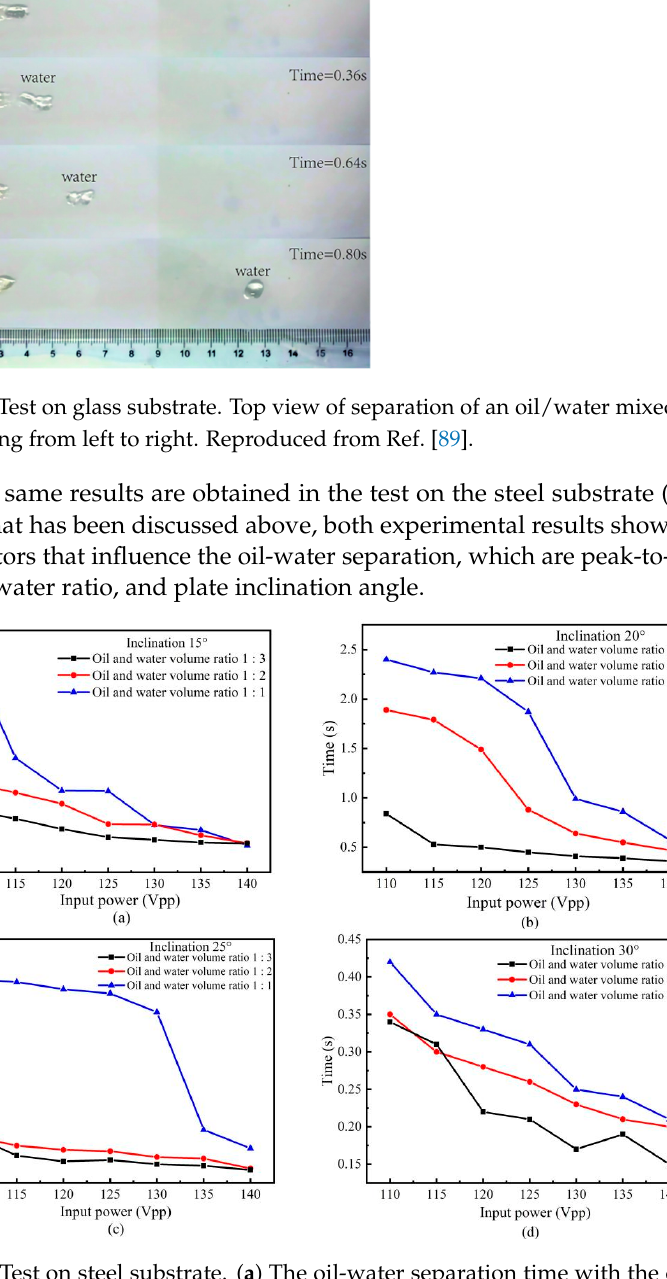
Figure 9. Test on steel substrate. ( a ) The oil-water separation time with the different input power at the plate inclination of 15 ◦ , ( b ) the oil-water separation time with the different input power at the plate inclination of 20 ◦ , ( c ) the oil-water separation time with the different input power at the plate inclination of 25 ◦ , ( d ) the oil-water separation time with the different input power at the plate inclination of 30 ◦ . Reproduced from Ref.